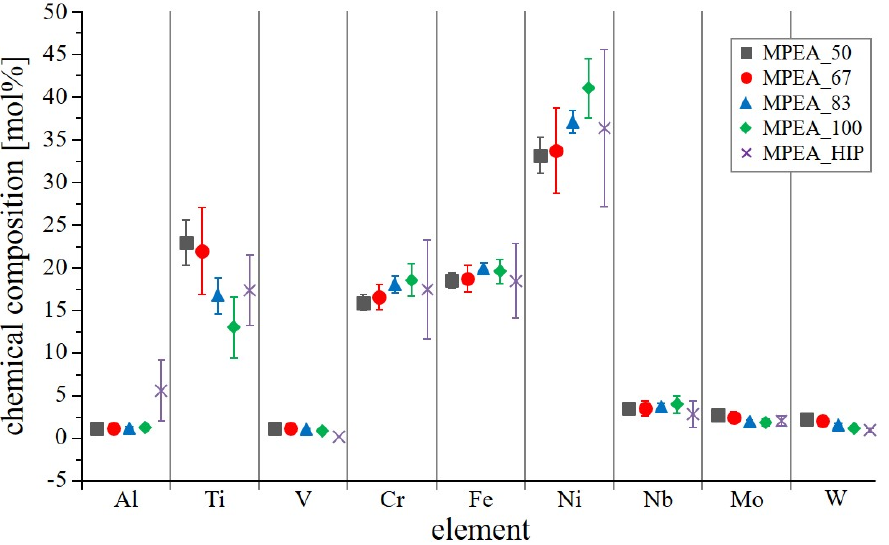
Figure 10. Average chemical composition of samples detected by EDS-line scans within the steady-state region.